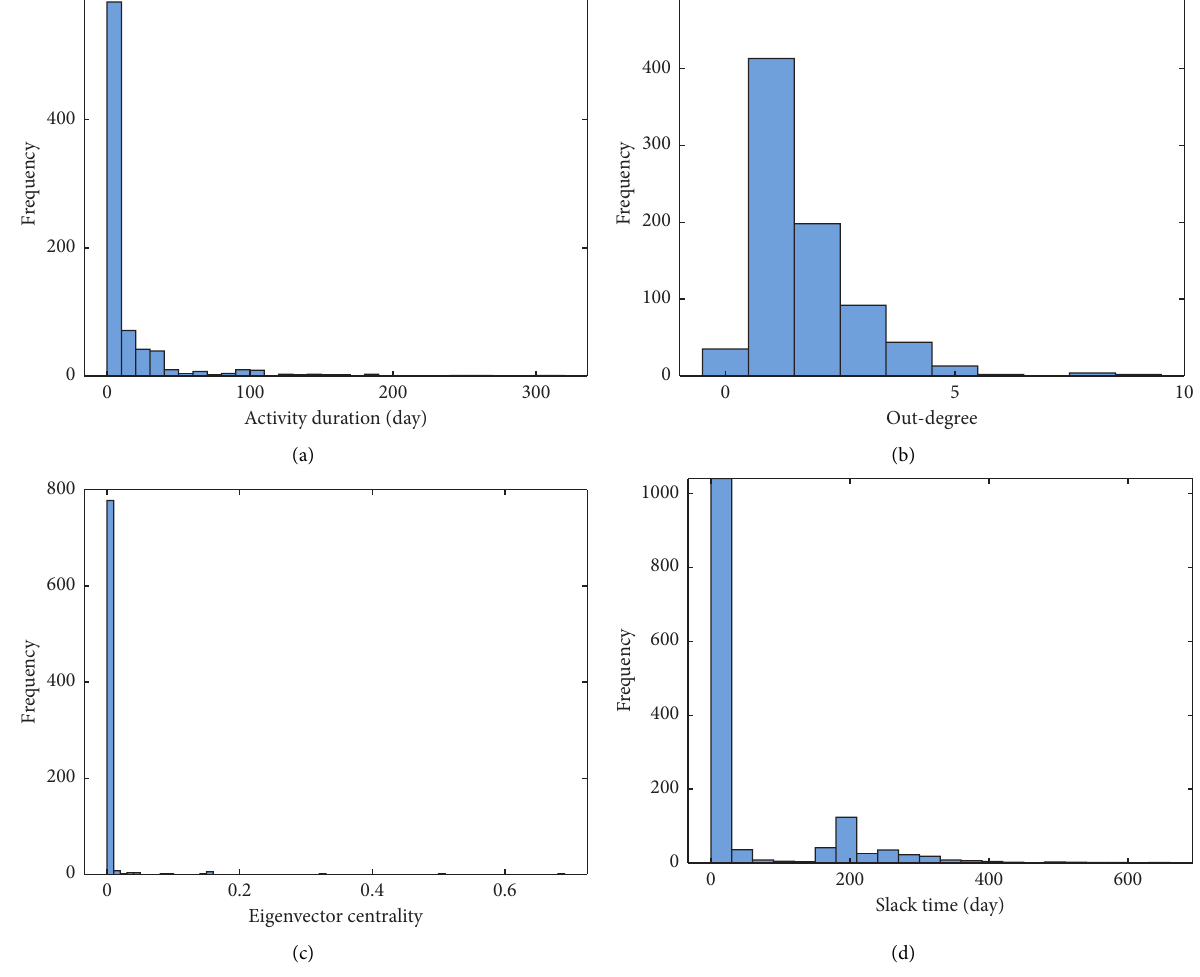
Figure 7(c), and β D � 2 , 5 , 7 in Figure 7(d). Using β K as an example, different nodes have different out-degrees, which � 3 , 8 in allows β to have different impacts on each node. When S K